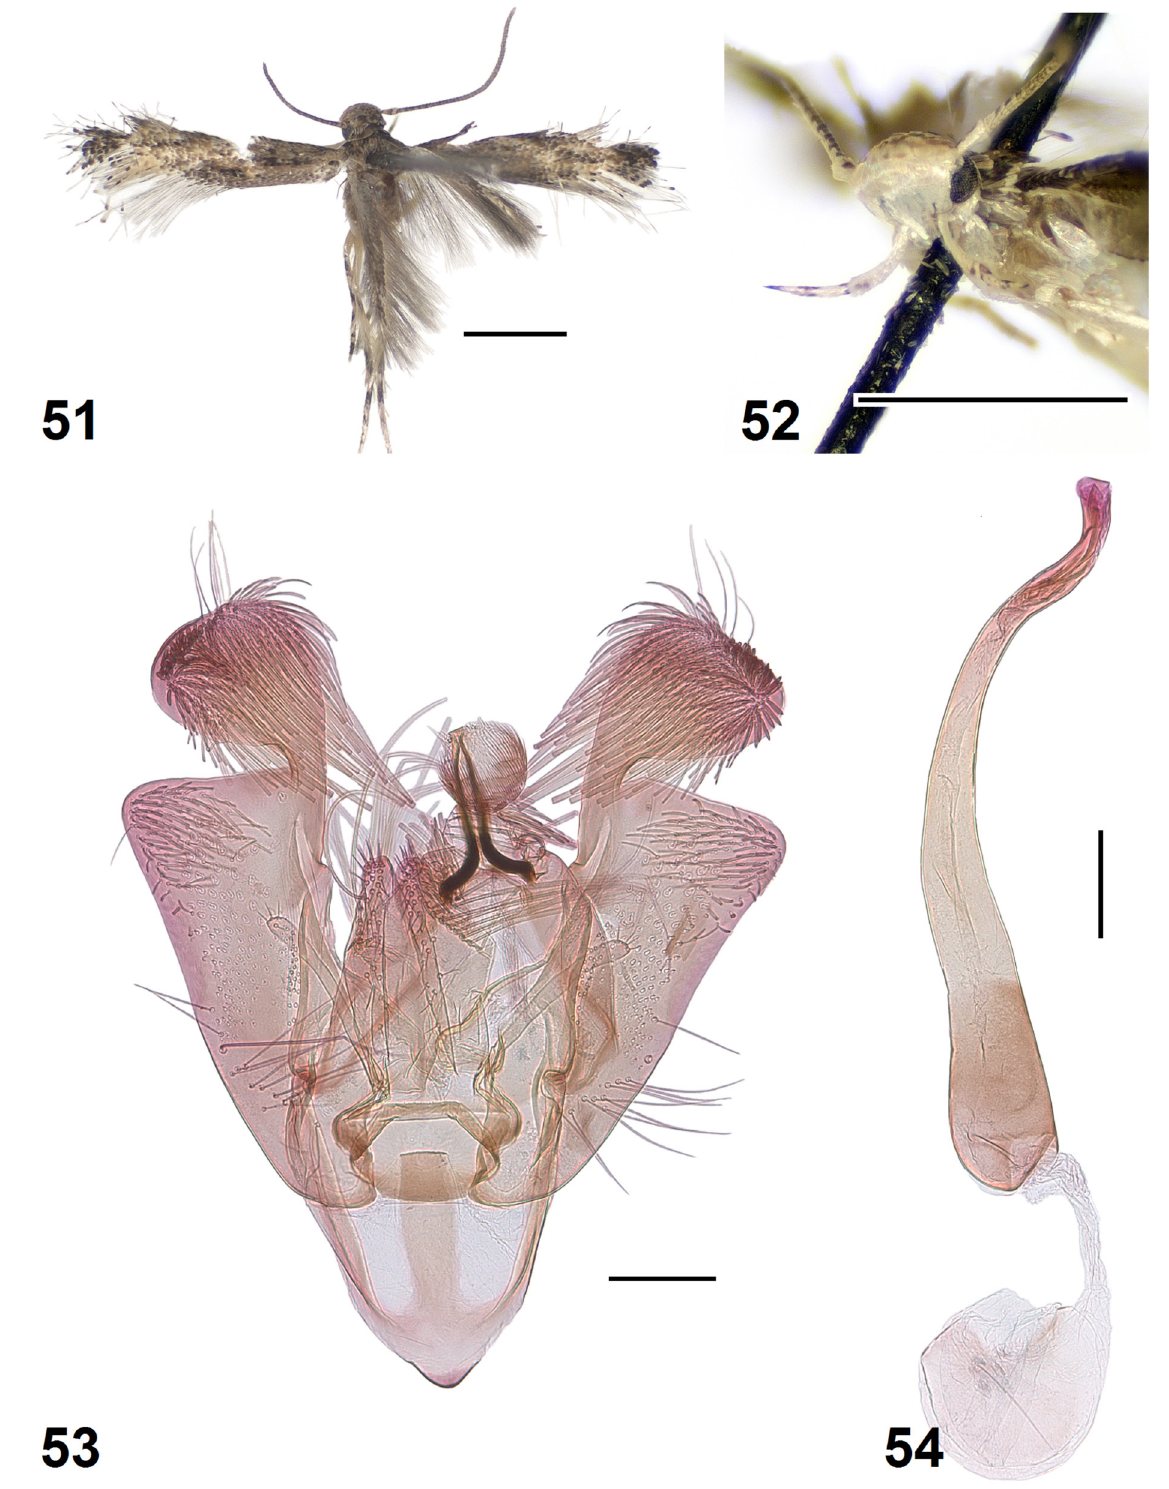
Figs 51–54. Elachista phichaiensis Sruoga & Kaila sp. nov., holotype, ♂ (MZH VS3/2.11.18). 51 . Adult. 52 . Head, latero-frontal view. 53 . General view of male genitalia (phallus removed). 54 . Phallus. Scale bars: 51–52 = 1 mm; 53–54 = 0.1